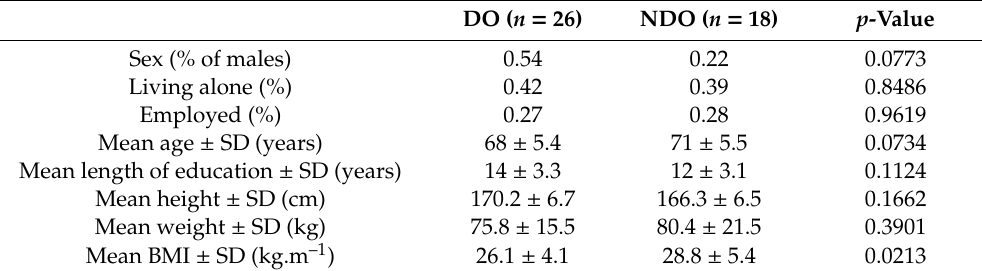
Table 1. Demographic data of dog owners (DO) and non-dog owners (NDO).